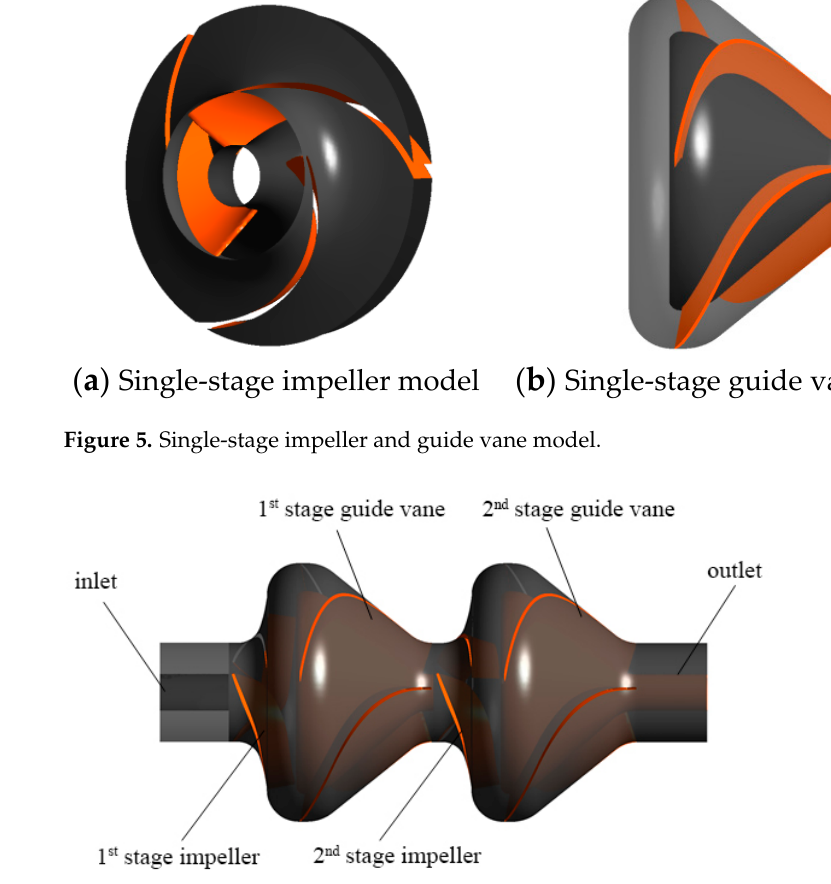
Figure 6. Structure model diagram of mining pump.